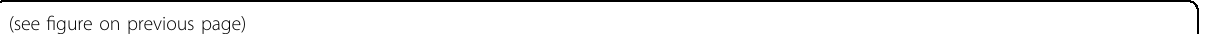
Fig. 3 Analysis of osteoclast progenitor cells in the bone marrow, typical marker expression in macrophages, and transmigration of preOCs. a , b Bone marrow cells were analyzed by FACS. a Representative density plots of Csf1r + bone marrow cells. b The percent frequency of osteoclast progenitor cells (red box, Csf1r + c-Kit + Cd11b dull ) in (A) is shown as the mean ± SD; * P < 0.05. c BMMs were analyzed by FACS. The expression of Csf1r is shown in whole cells (left), and Csf1r + -gated cells were analyzed for Rank ((y-axis) and Cd11b ((x-axis) expression (right). d BMMs transduced with Lifeact-mCherry were cultured with M-CSF and RANKL for 3 days to generate preOCs. Lifeact-mCherry-labeled preOCs were overlaid on a GFP + MC3T3-E1 osteoblast monolayer with the continued presence of osteoclastogenic cytokines. Z-plane images were acquired after 30 min (upper) or 12 h (lower) via confocal microscopy. Scale bars, 10 μ m